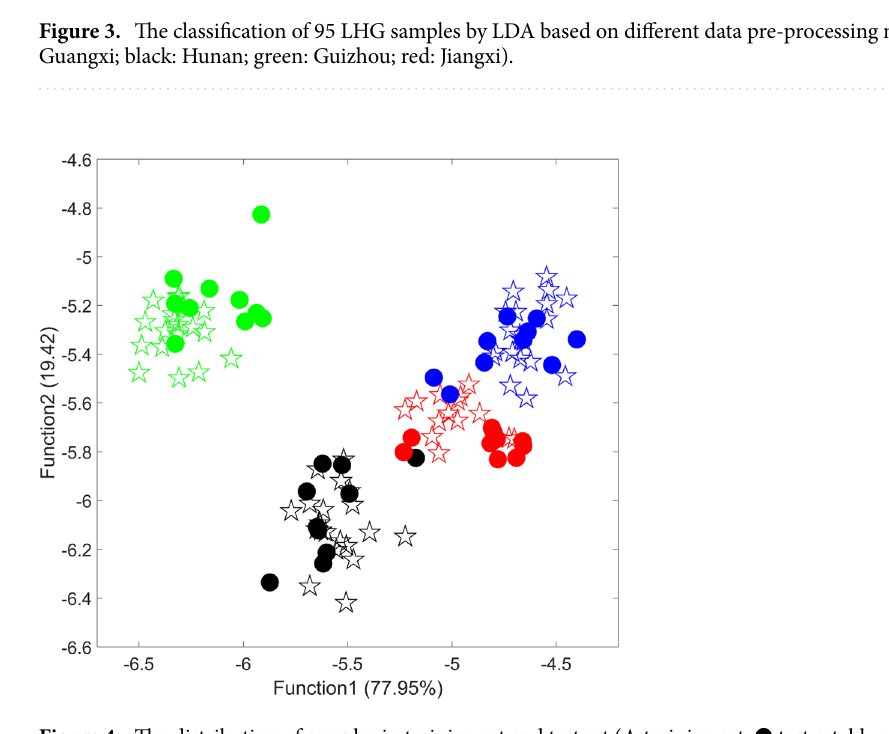
Figure 4. The distribution of samples in training set and test set ( ☆ training set; ● test set; blue: Guangxi; black: Hunan; green: Guizhou; red: